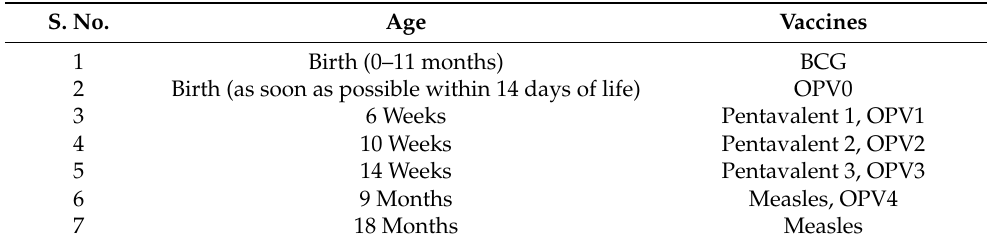
Table 1. Childhood vaccination schedule Afghanistan. S. No. Age